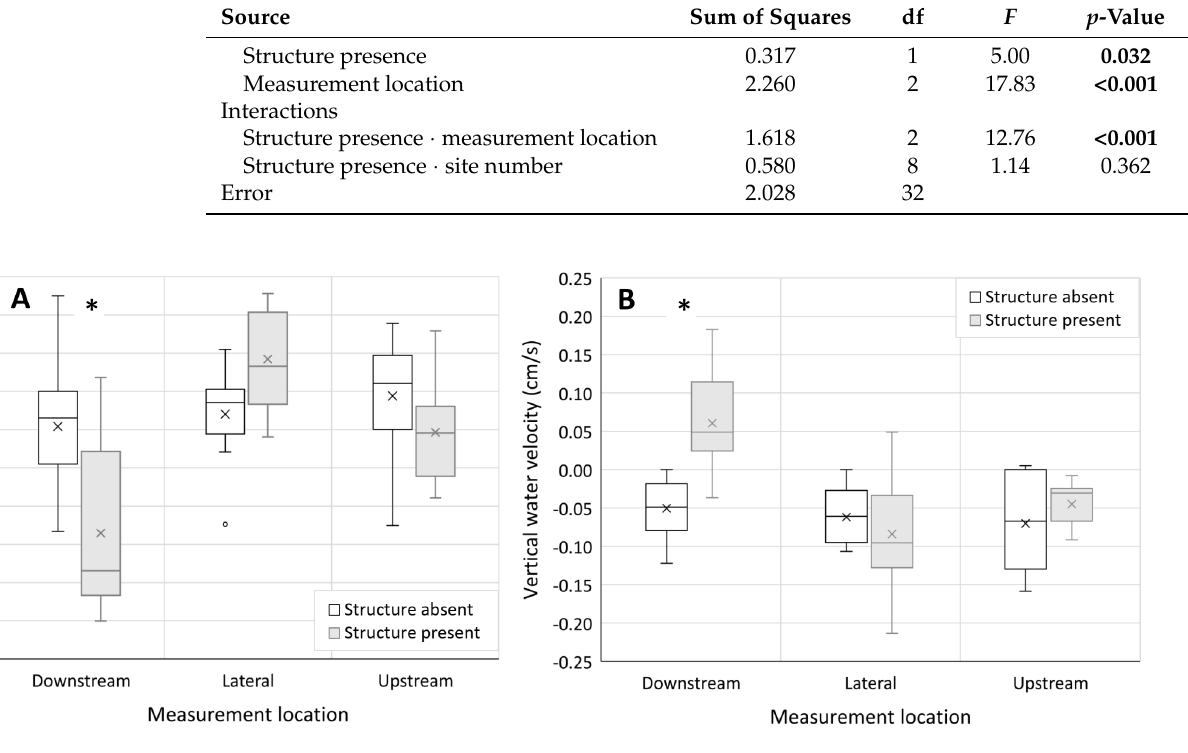
Figure 3. Box and whisker plots of ( A ) horizontal and ( B ) vertical surface water velocities at measurement locations (downstream, lateral, and upstream) where in-channel structure was present (grey plots) versus absent (open plots). The box represents the data range between 1st and 3rd quartile, the horizontal line in the box represents the median, the x in the box represents the mean, and the whiskers represent the minimum and maximum values excluding the outliers (small circles). Asterisks (*) indicate a significant difference between measurement locations containing in-channel structure and lacking in-channel structure.